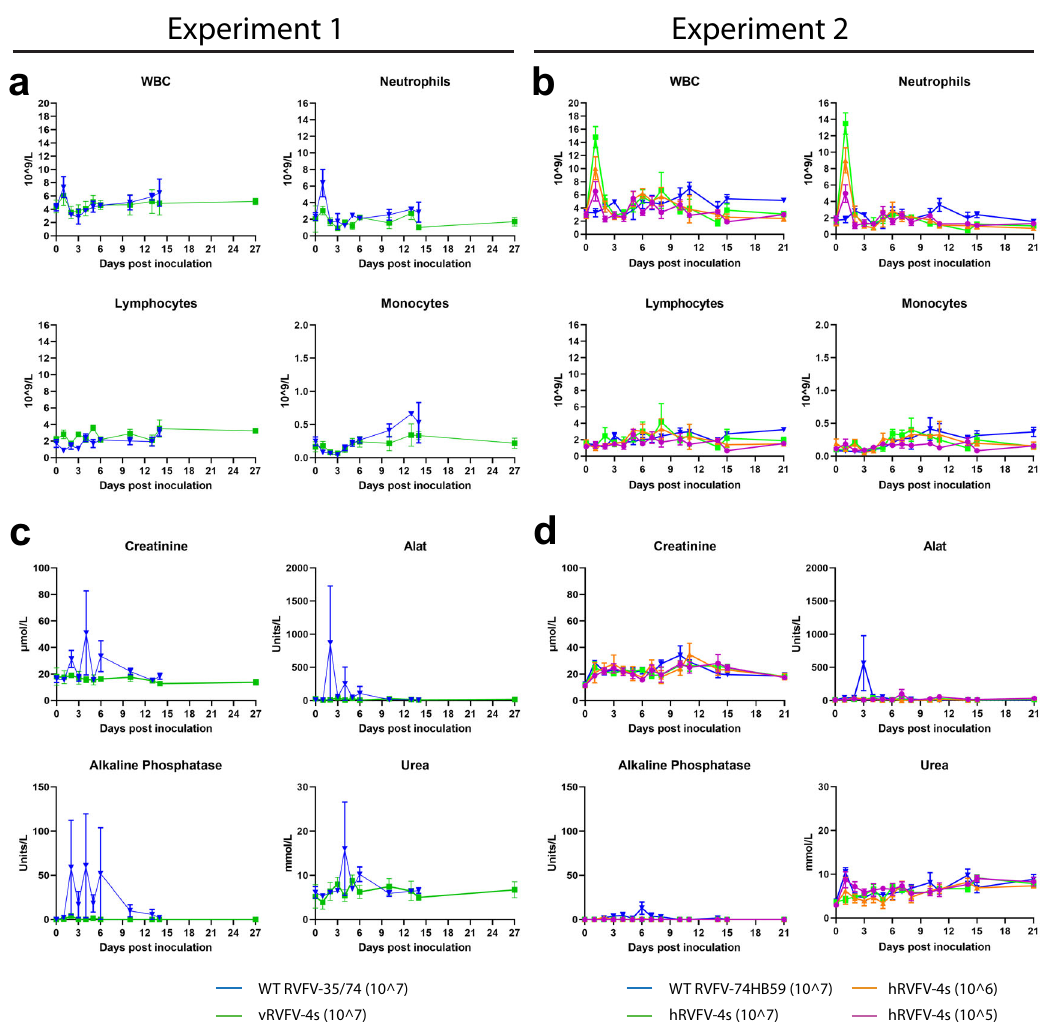
Fig. 4 Short-term neutrophilia following hRVFV-4s inoculation and no changes in blood chemistry following either vRVFV-4s or hRVFV- 4s inoculation. WBC, neutrophil, lymphocyte, and monocyte counts measured in blood collected from animals from experiment 1 ( a ) and animals from experiment 2 ( b ) at the indicated timepoints. Creatinine, alanine aminotransferase (ALAT), alkaline phosphatase (ALP), and urea levels in plasma measured in animals from experiment 1 ( c ) and animals from experiment 2 ( d ), at the indicated timepoints. In the fi rst week post inoculation, blood samples were obtained every other day from an individual animal (Fig. 1). Averages and SEM are presented for each group. No statistical analysis could be performed due to the low number of measurements per time